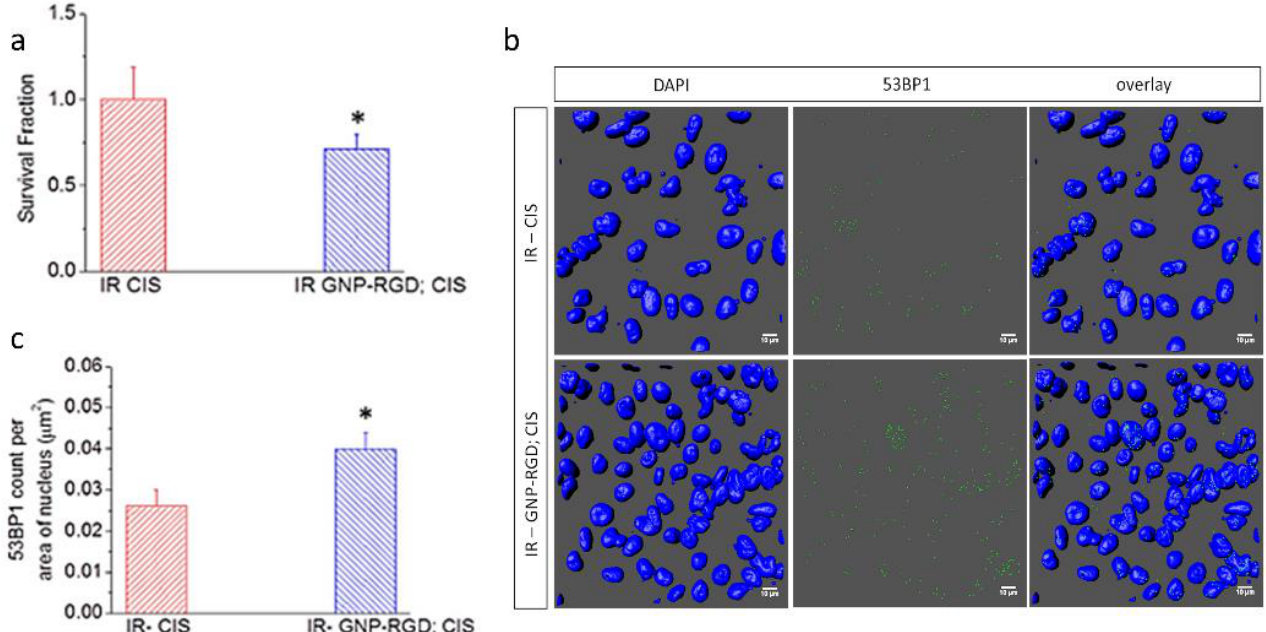
Figure 5. Combination with GNPs and cisplatin in RT. ( a ) Cell survival fraction of MDA-MB-231 cells treated with cisplatin (CIS) and GNP- arginine-glycine-aspartic acid (RGD); CIS prior to 2 Gy, 6 MV radiation. Data are means ± S.E.M. for n = 3. * represents statistically significant difference (unpaired t -test, p < 0.05); ( b ) Qualitative representation of DNA double-strand breaks (DSBs) in MDA-MB-231 cells treated with CIS and GNP-RGD; CIS prior to 2 GY, 6 MV X-ray radiation. The nucleus is stained with DAPI (shown in blue) and the markers for DNA DSBs, 53BP1, are shown in green. Scale bar = 10 µm; ( c ) Quantitative analysis of ( b ). Reproduced from [68], MDPI, 2018.